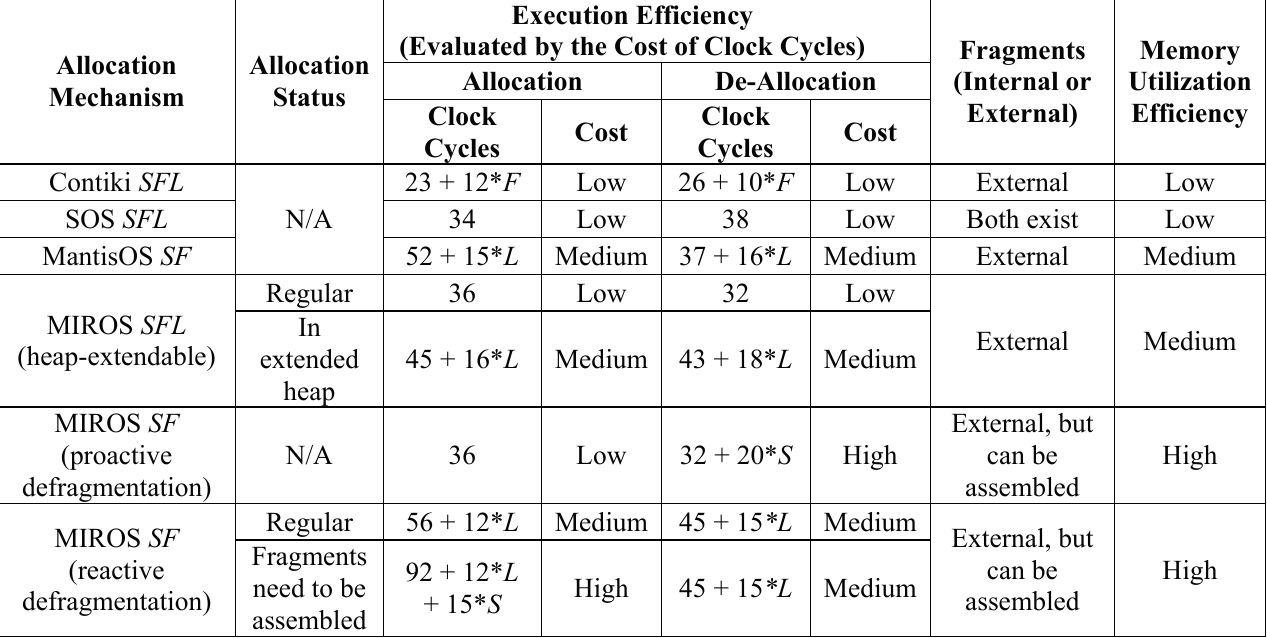
Table 4. Feature comparison of the different